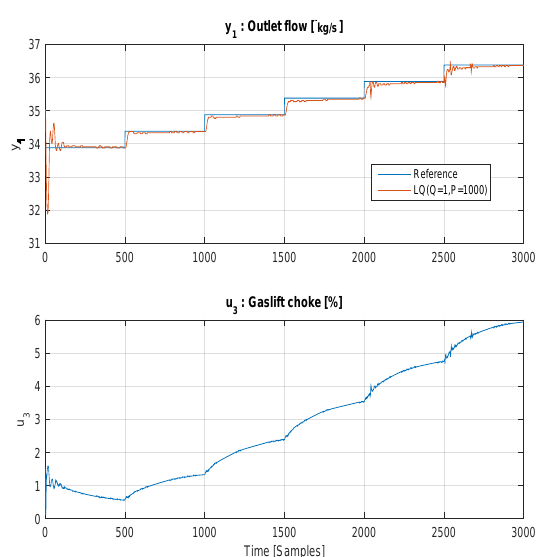
Figure 9: Implementation in K-Spice of the optimal controller, LQR, controlling outlet flow, y 1 , with Gaslift choke u 3 . The weights are Q = 1 and P = 1000. Results from a MATLAB script associated with Fig. 4. Case